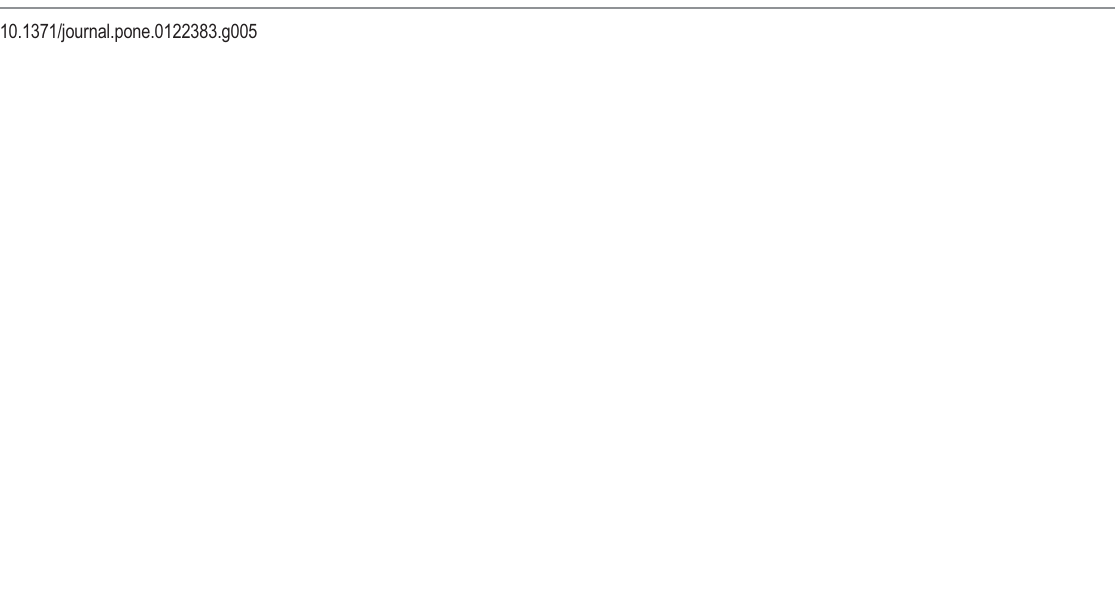
Fig 5. Hemoglobin bias plot. Bland and Altman plot shows the hemoglobin bias of each pair of samples (in g/dL). The solid line indicates the mean bias and the value is 0.08. The green line indicates 95%CI of mean bias (-0.05 to 0.21). The orange line indicates the 95% LOA of the bias (-1.77 to 1.92). The orange line indicates zero